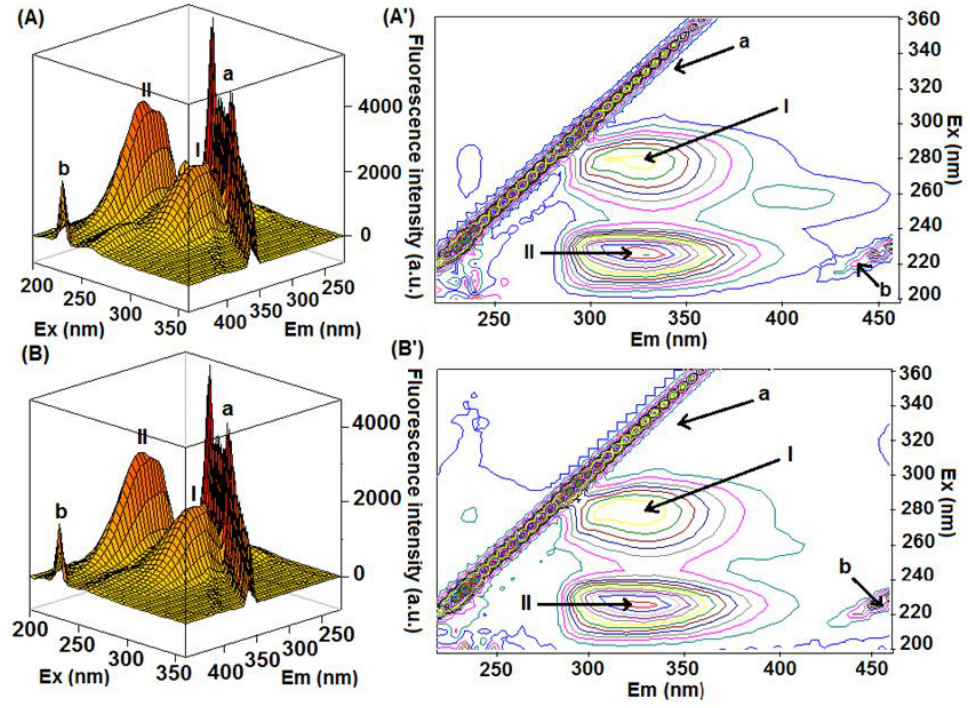
Figure 6. The 3D-fluorescence spectra and the corresponding contour maps for ( A , A’ ) HSA and ( B , B’ ) HSA:4-TPyP in pH = 7.4 at room temperature. [HSA] = 1.0 × 10 −6 M and [4-TPyP] = 1.32 × 10 − 6 M. Table 2. The 3D-fluorescence spectral characteristics for HSA and HSA:4-TPyP in pH = 7.4 at room temperature.